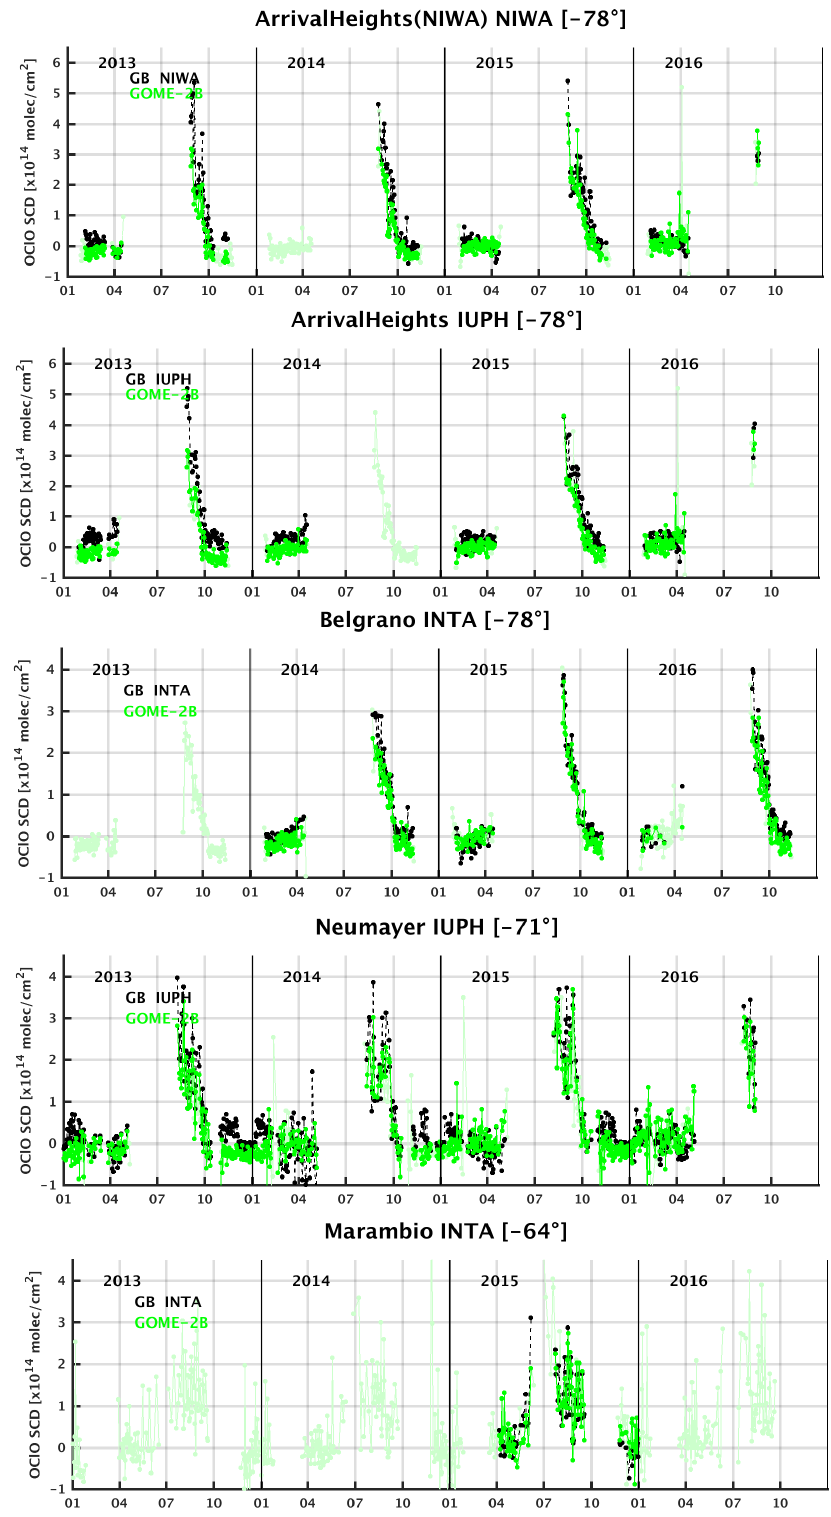
Figure 10. Time series of GOME-2B (green) OClO daily mean slant column data co-located with ground-based (black) measurements performed at each Antarctic station. The lighter transparent green color is used for GOME-2B when there are no ground-based measurements.